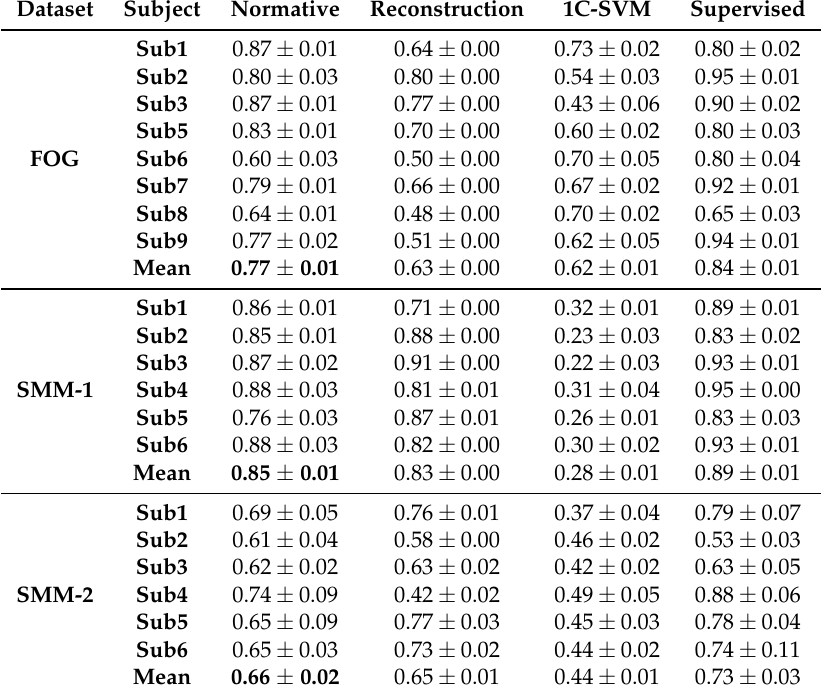
Table 2. The average of AUC results for novelty detection using normative modeling, reconstruction-based and one-class SVM on three benchmark